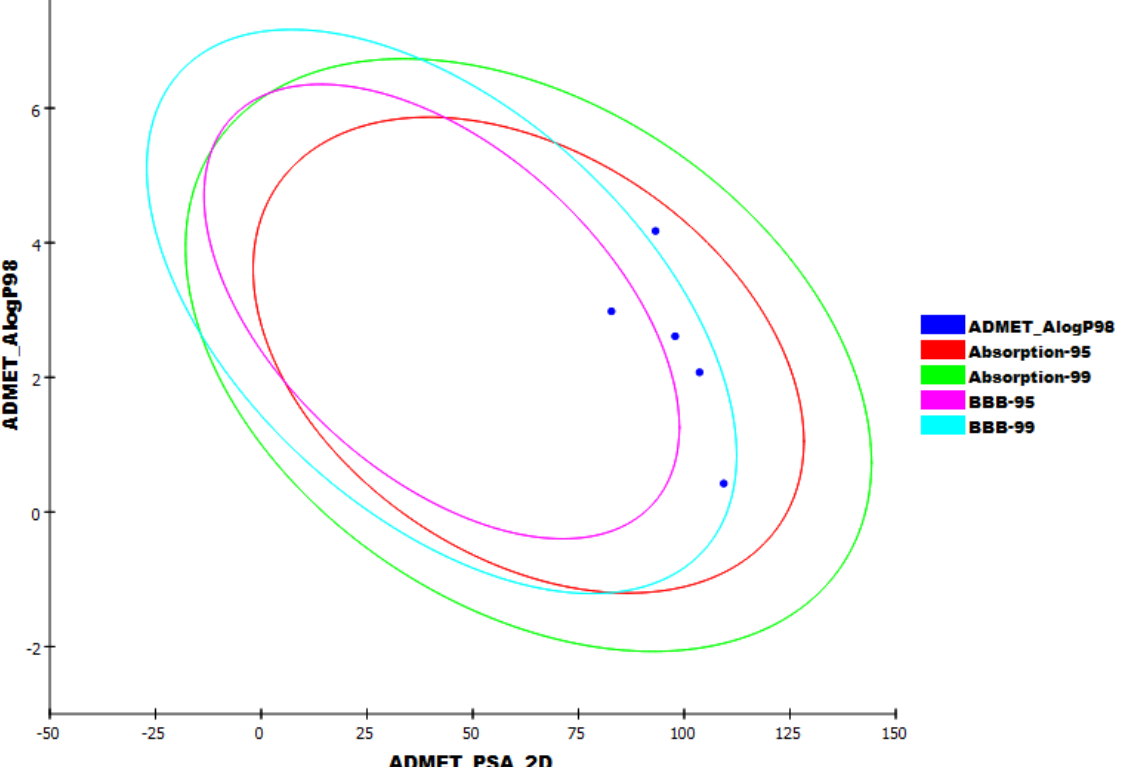
Figure 12. The ADME plot of the synthesized compounds. The compound that encompassed by the ellipses represent good values of intestinal absorption and other ADMET parameters. Additionally, BBB and Int ‐ A models were indicated as ellipses of 95% and 99% confidence